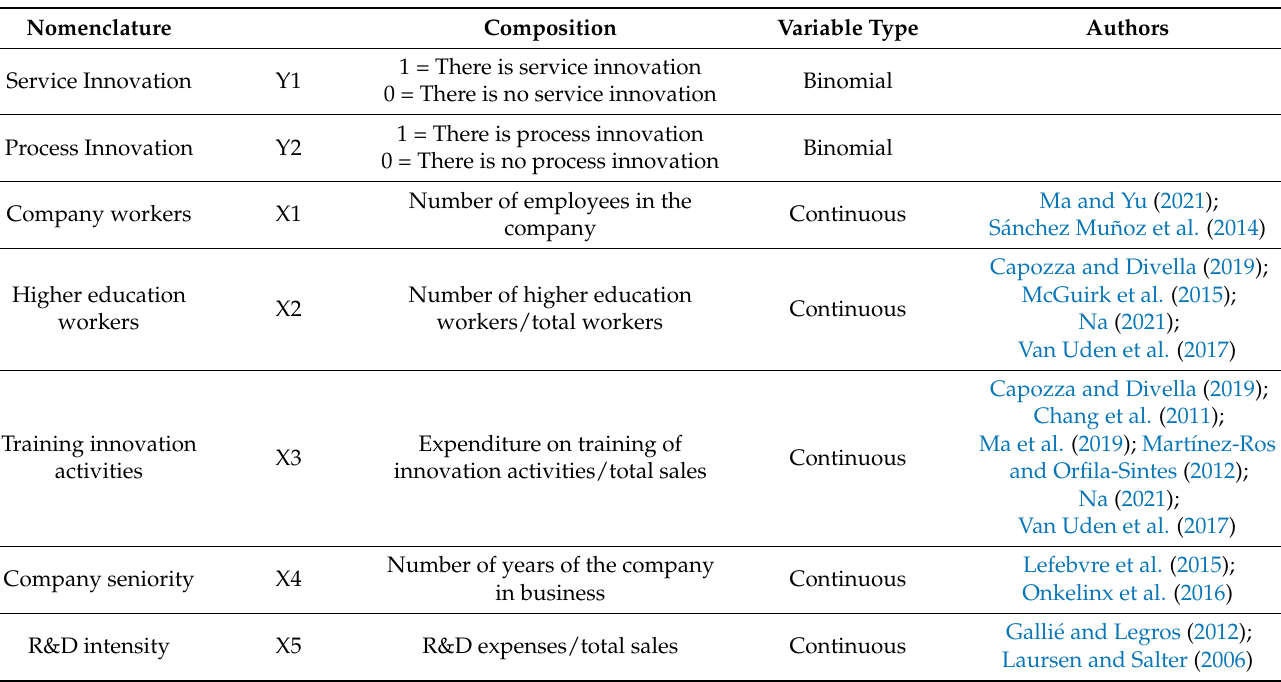
Table 1. Variable